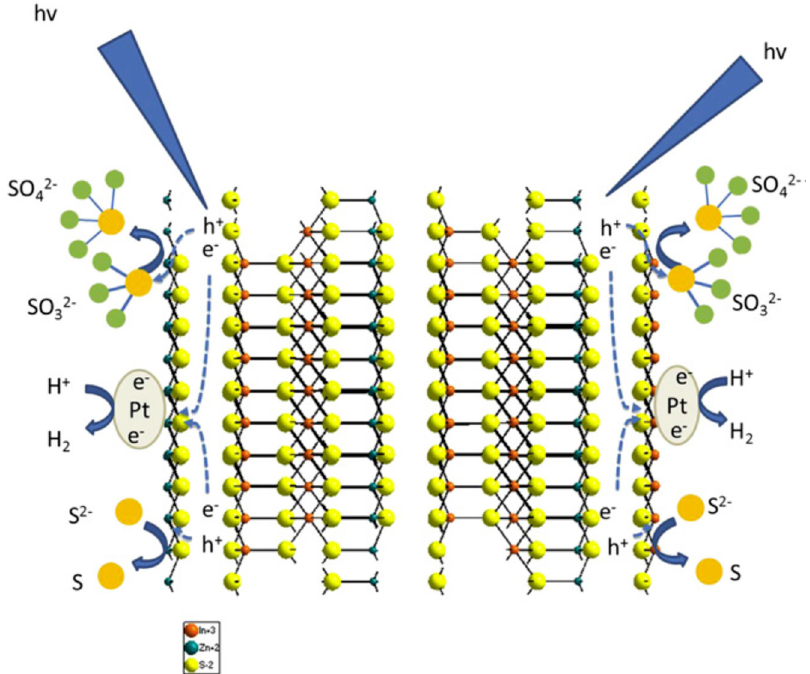
Figure 8. Schematic illustration of the hydrogen generation reaction on the {006} facets of the Pt loaded ZnIn 2 S 4 photocatalysts. Figure adapted from reference [108].